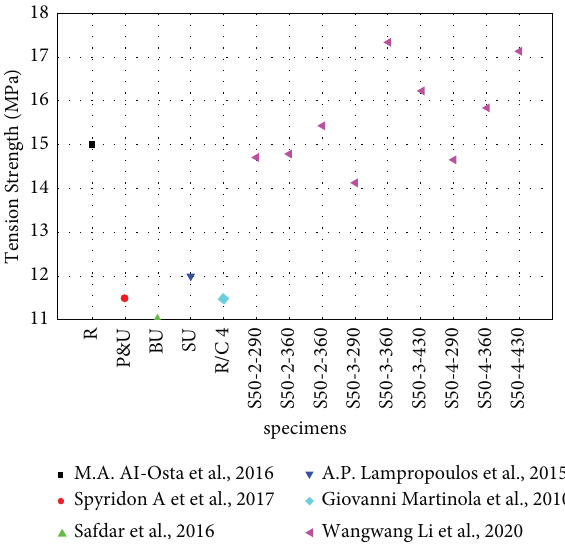
Figure 2: Te distribution of UHPC tension stress.